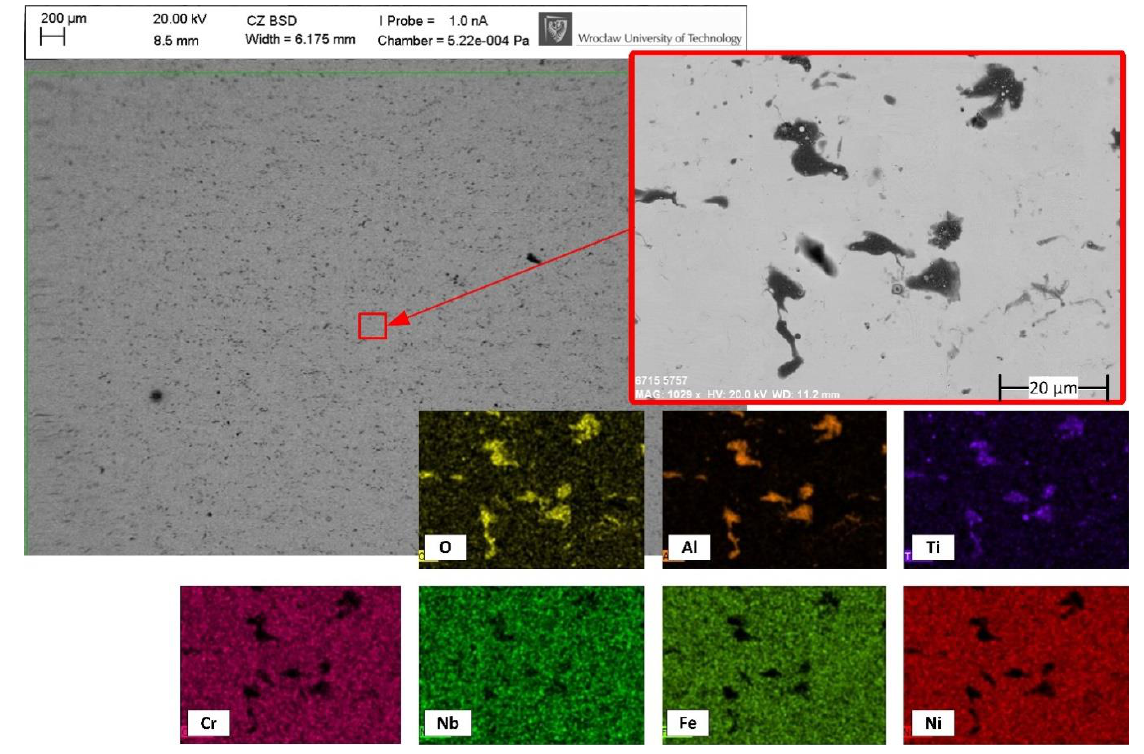
Figure 7. Back-scattered electron graph and EDS mapping showing the top-view and chemical elements of the sample (5.a) polished with 85% overlap in the argon chamber.